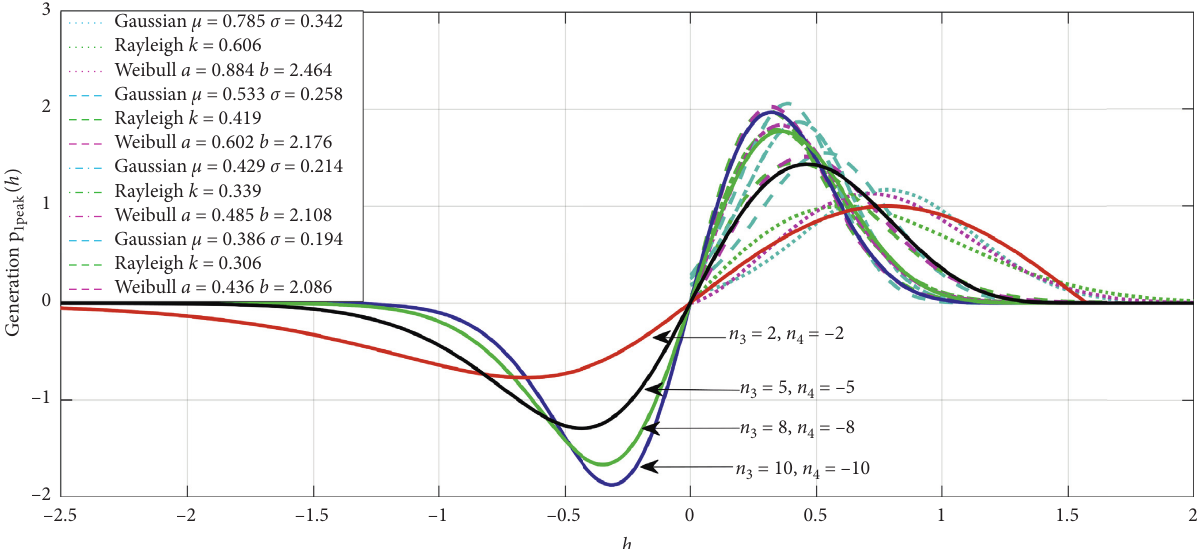
Figure 21: Generalized peak PDFs of ATHNPS for various values of n